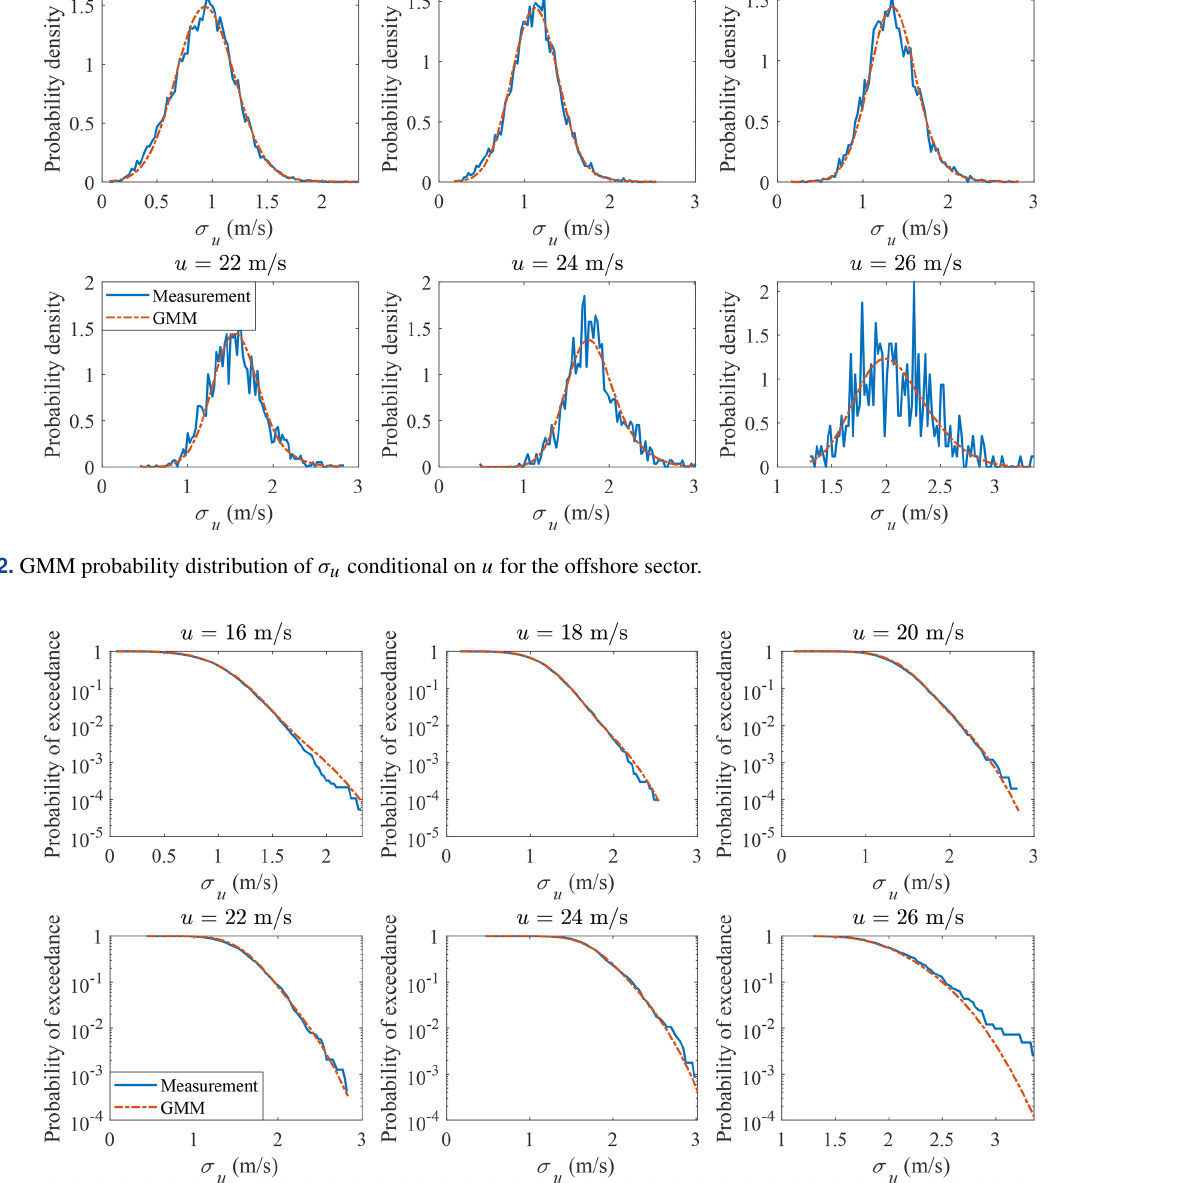
Figure 13. GMM probability of exceedance of σ u conditional on u for the offshore